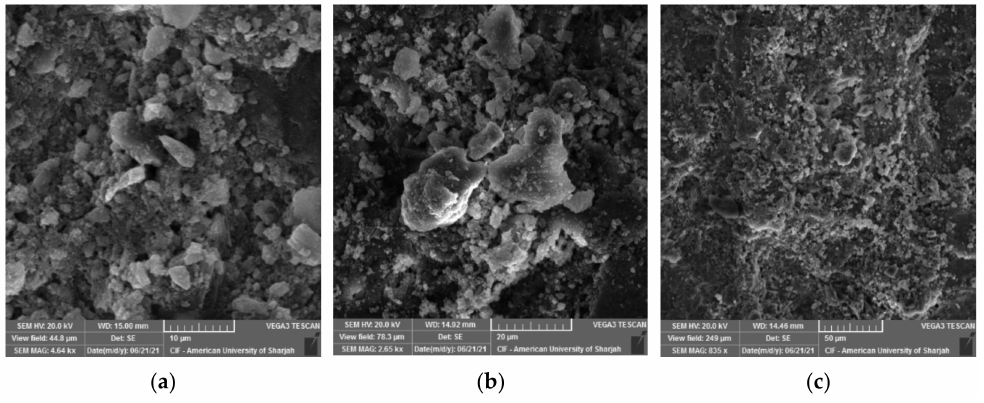
Figure 9. RPC microstructure HAC. ( a ) 12 h; ( b ) 24 h; ( c ) 48